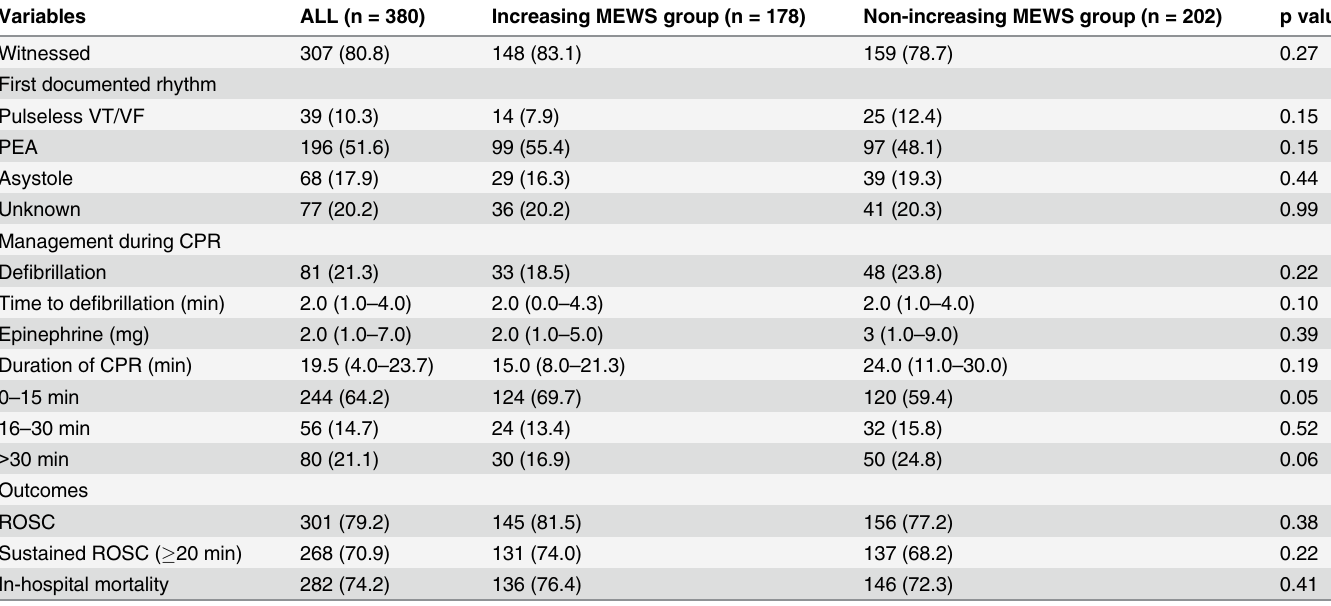
Table 5. Cardiac arrest and Outcome Characteristics of the Study Population.